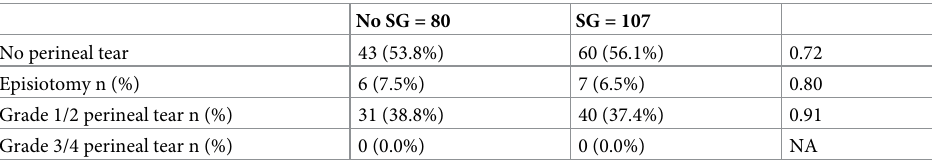
Table 3. Differences in rates of perineal tears between women with and without